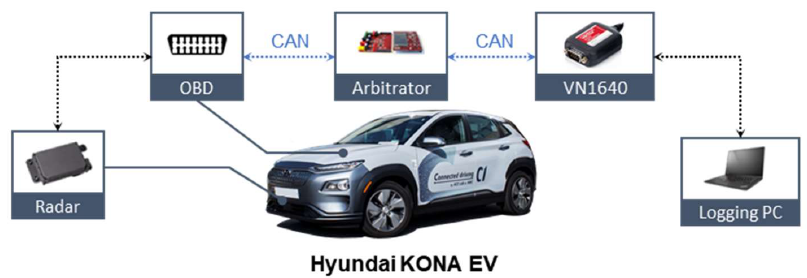
Figure 1. Vehicle configuration. Table 1. Radar specification.